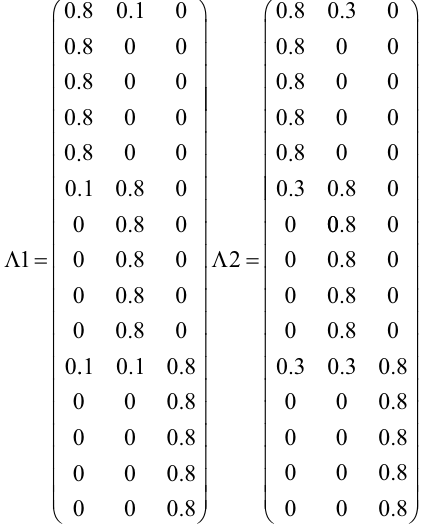
Supplementary Table 9 . The correlations between the population factor means and the estimated alignment factor means computed over groups and averaged over replications were always above 0.98 so we could conclude that alignment could produce reliable factor mean rankings. When the model had no noninvariant parameters, the minimal group size required for alignment was 250 when the amount of groups was three, the minimal group size was 150 when the amount of groups was nine, and 200 when the amount of groups was 15. When there were noninvariant parameters in the model, with all the two magnitudes of noninvariance (e.g., large, small) and all the two noninvariance rates (e.g., 10, 20%), the minimal group size required for alignment was 350 when the amount of groups was 3, and it was 250 when the amount of groups was 15. The minimal group size was 150 when the magnitude of noninvariance was large and amount of groups was nine, or when the magnitude of noninvariance was small, noninvariance rate was 10%, the amount of groups was nine; the minimal group size was 200 when the magnitude of noninvariance was small, the amount of groups was nine, but the noninvariance rate was 20%.